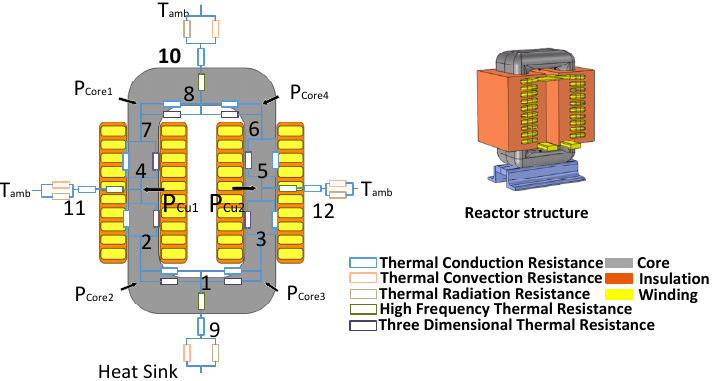
Figure 5. Equivalent thermal network model of reactor. Table 2. Definition of each node.